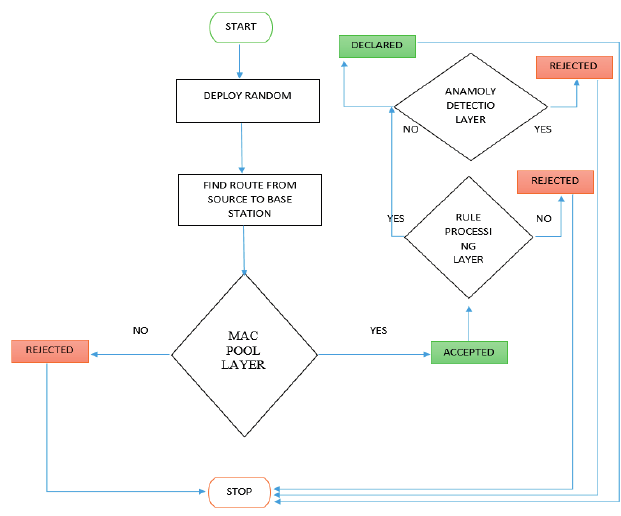
Figure 3. Selective Forwarding Attack Detection Flowchart.